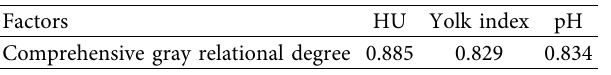
Table 6: Te comprehensive gray relational degree between each egg freshness index and ovomucin concentration.